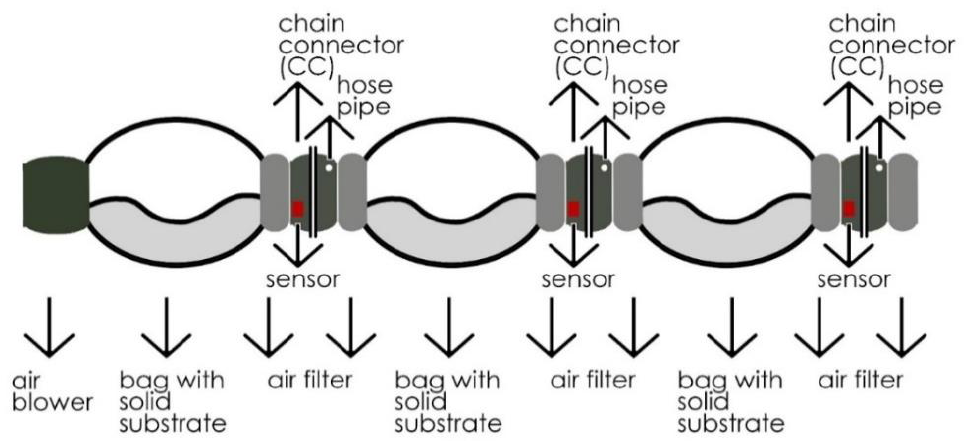
Figure 2. MCB—3 Unit chain Figure 2. MCB — 3 Unit chain scheme.